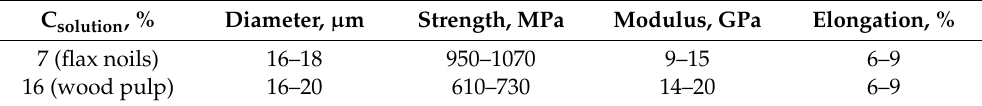
Table 2. Mechanical properties of fibers spun from flax noils cellulose and wood pulp. C solution , %